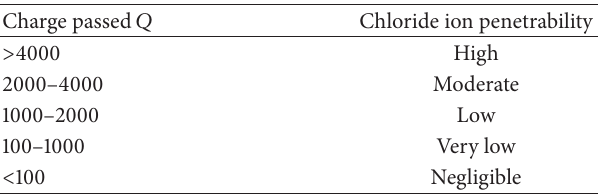
Table 4: Chloride ion penetrability based on charge passed accord- ing to ASTM C1202